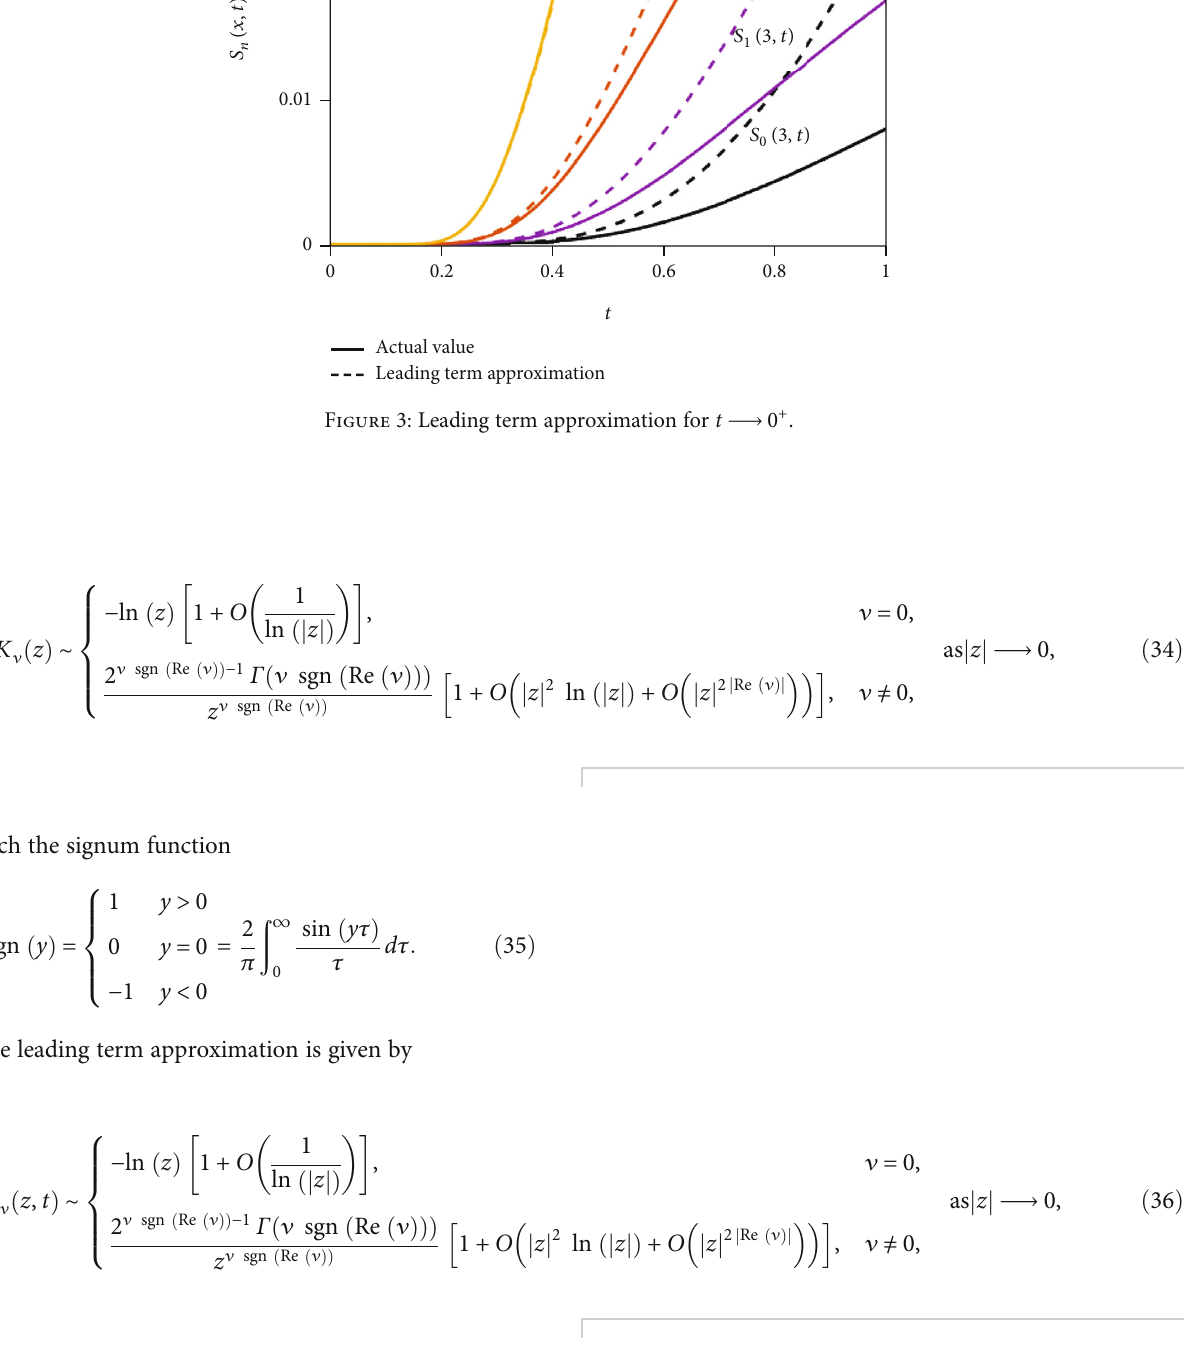
Figure 4. As can be observed, the agreement is better for lower integer order n .